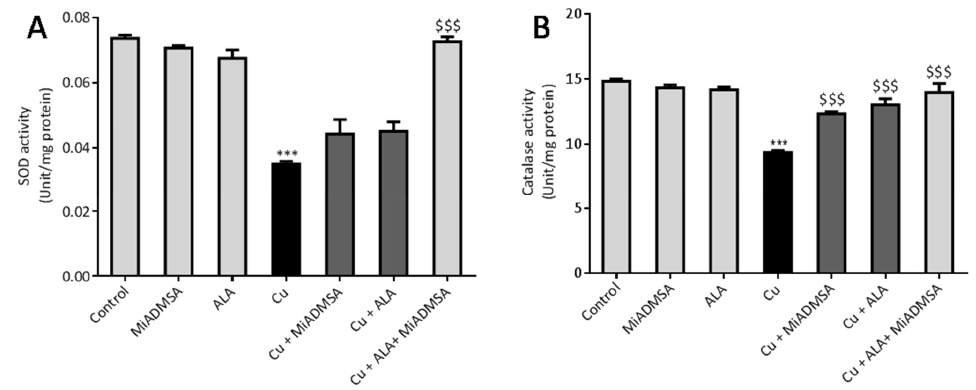
Figure 12. The MiADMSA and ALA combination therapy restored the altered brain SOD and catalase levels. ( A ) Brain SOD level; ( B ) Brain catalase level. All the values are expressed as mean ± S.E.M. ( n = 6), *** p < 0.001 vs. control and $$$ p < 0.001 vs. Cu.